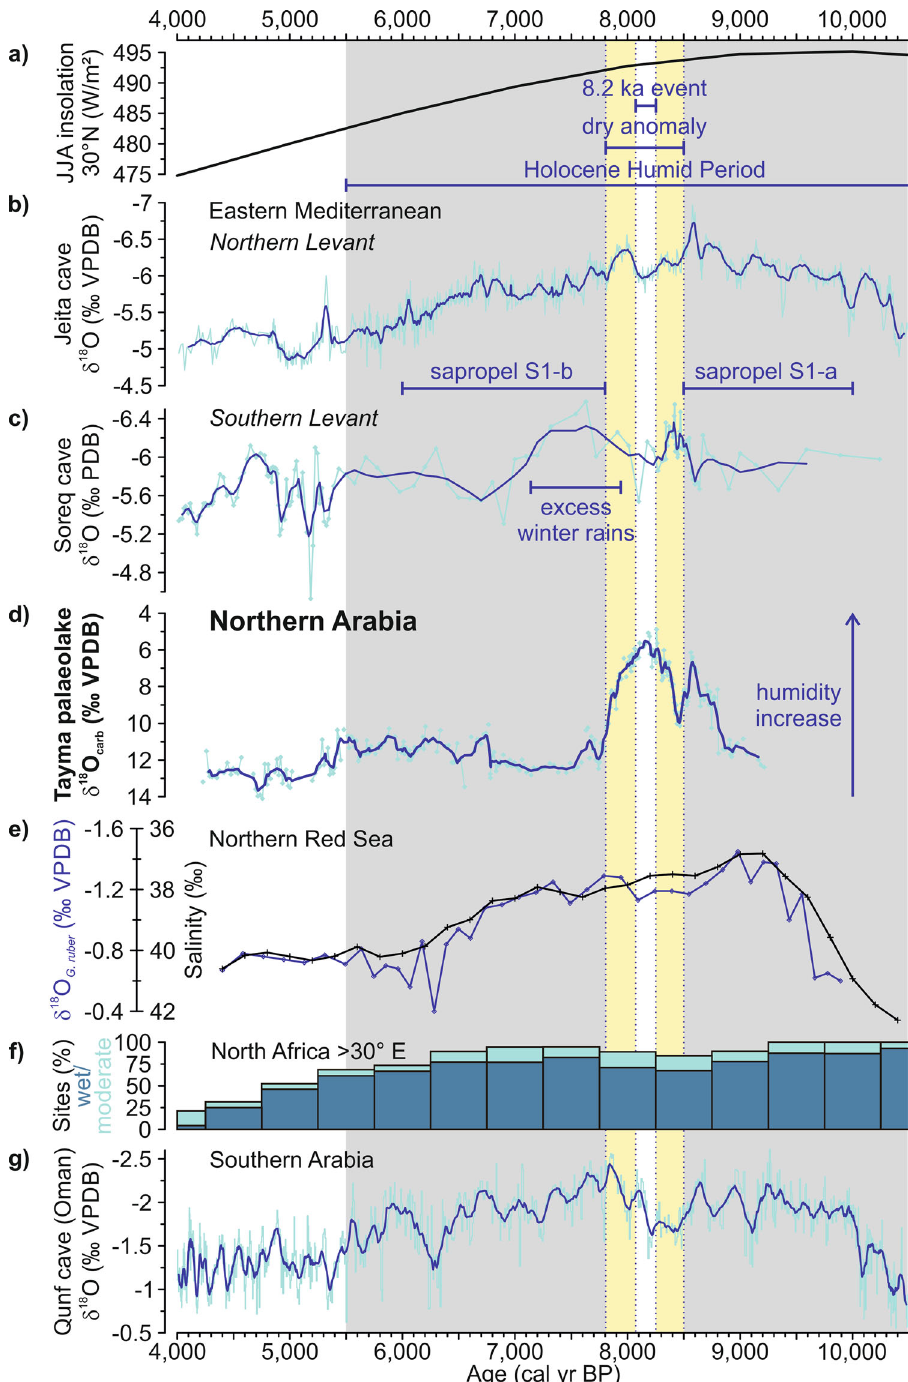
Fig. 3 Oxygen isotopes recording humidity changes during the early to middle Holocene Humid Period (HHP) across the Eastern Mediterranean to Southern Arabia regions. a Summer insolation at 30°N 81 , duration of the HHP sensu ref. 18 (grey), the low-latitude dry anomaly 48 (yellow), and the 8.2 ka cold event in Greenland ice cores 82 (white bar); b speleothem δ 18 O from Jeita cave (Lebanon) 28 , and c Soreq cave (Israel) 26,27 , with the timing of sapropel formation in the Eastern Mediterranean Sea and excess winter rain in the Southern Levant 51 ; d δ 18 O carb from the Tayma palaeolake (this study); e δ 18 O G. ruber re fl ecting temperature, and calculated salinity changes from the Northern Red Sea (GeoB 5844-2) 13 ; f frequency histograms of lake records re fl ecting wet or moderately wet conditions in the East African Summer Monsoon domain >30°E 18 ; g speleothem δ 18 O from Qunf cave (Oman) 29 . All δ 18 O scales are reversed to re fl ect higher humidity upwards. Palaeoclimate sites are shown in Fig. 1a.